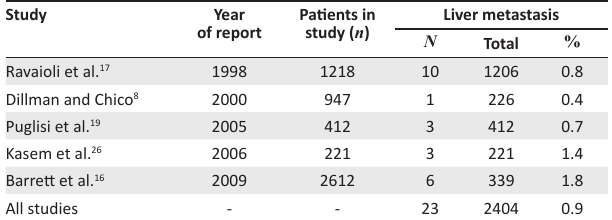
TABLE 2: Prevalence of bone metastasis in all stages of disease as detected by bone scan.